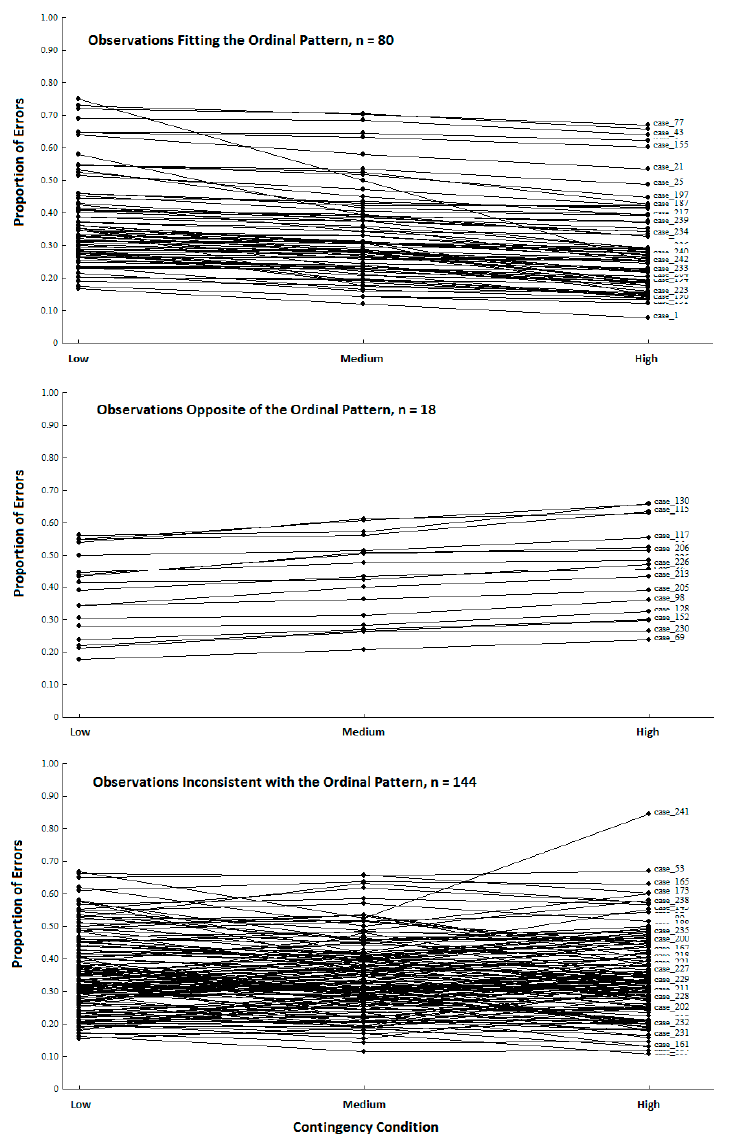
Figure 2. Proportions of errors committed on the Stroop task for the low, medium, and high contingency conditions. The results have been separated into three categories based on their ordinal patterns.